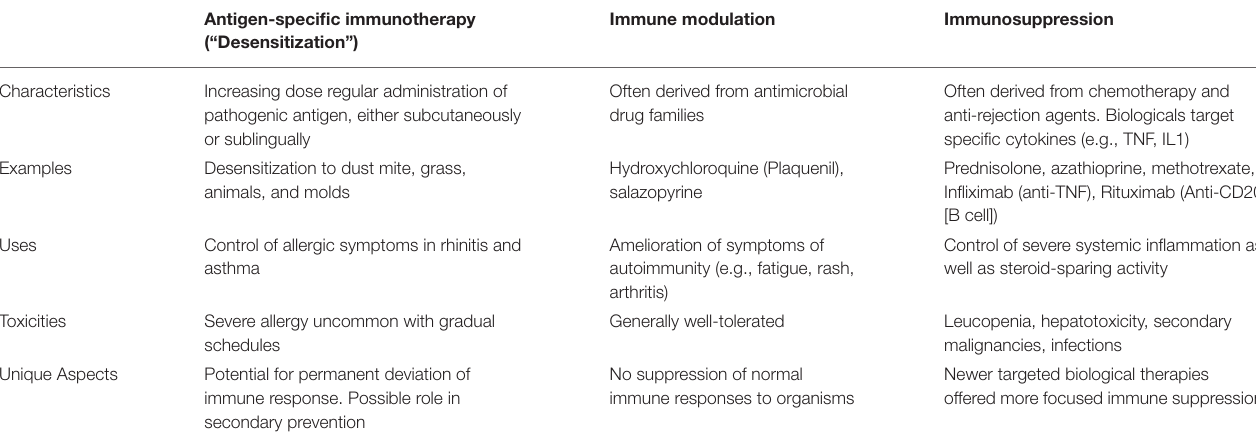
TABLE 3 | Immune modulating